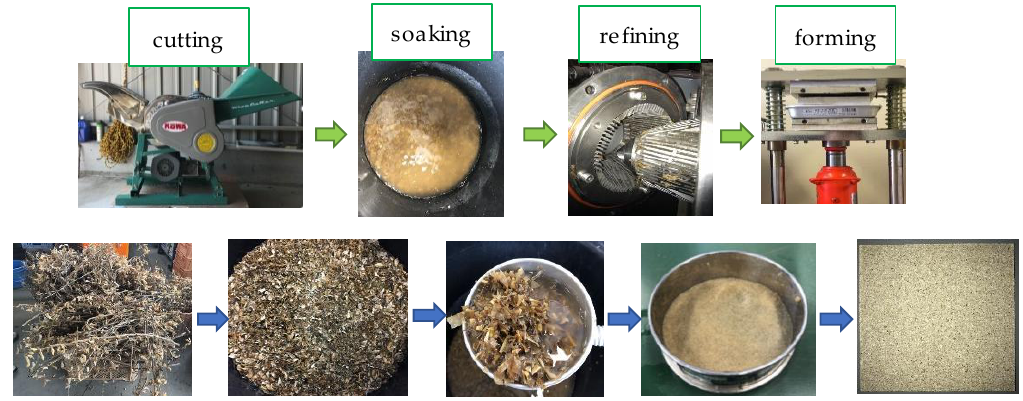
Figure 1. The making process of bio-board.